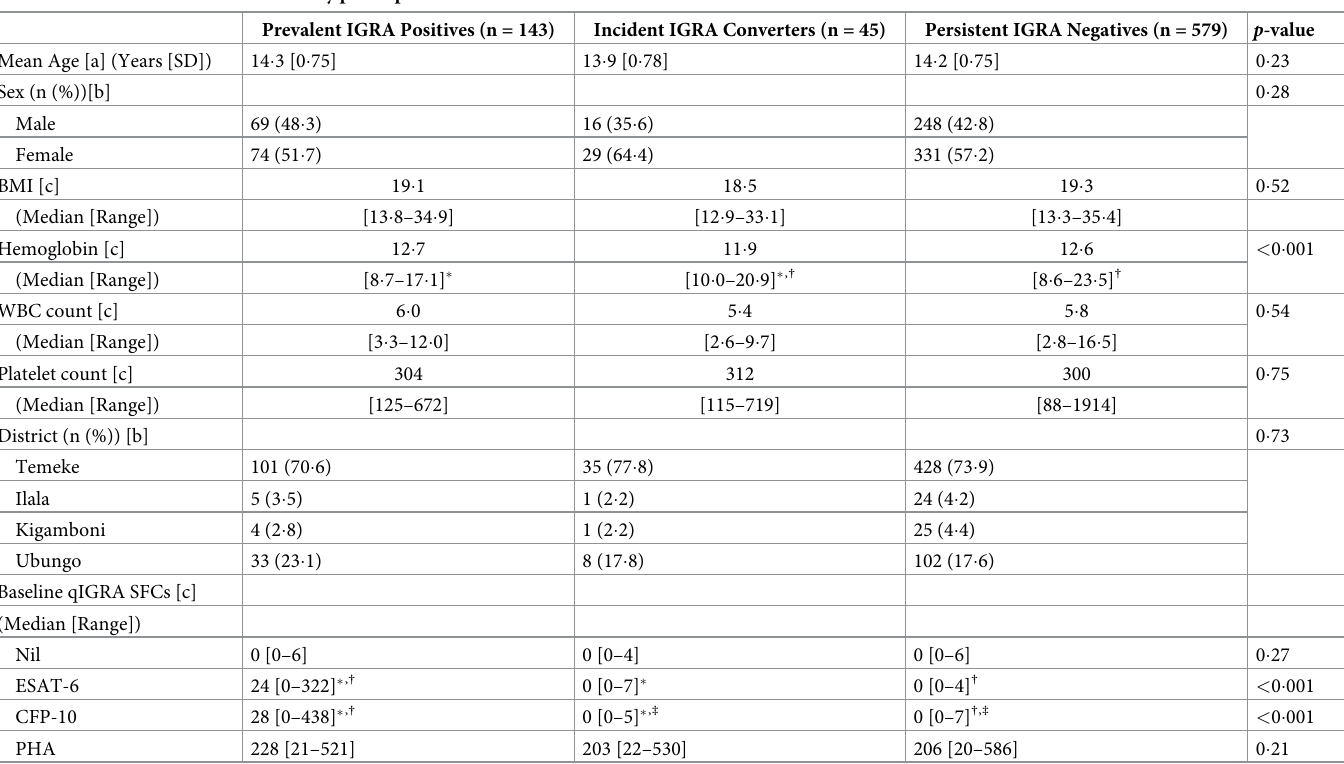
Table 3. Baseline characteristics of study participants.